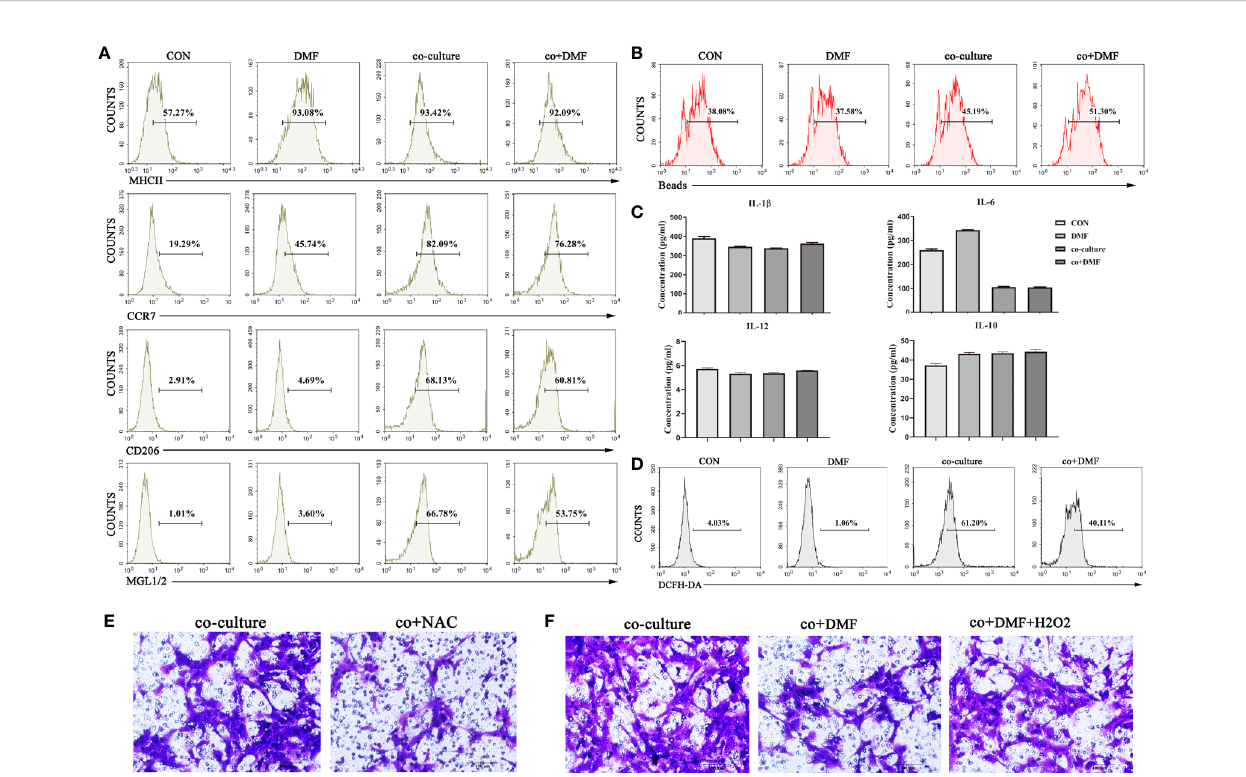
FIGURE 2 | DMF inhibits the pro-invasion ability of TAMs by reducing reactive oxygen species (ROS) production. (A) In the presence or absence of DMF, RAW264.7 cells were cultured alone or co-cultured with 4T1 cells for 48 hours, and the expression of membrane surface molecules (MHCII, CCR7, CD206, MGL1/2) of RAW264.7 cells was detected by fl ow cytometry. (B) In the presence or absence of DMF, RAW264.7 cells were cultured alone or co-cultured with 4T1 cells for 48 hours, and the phagocytosis of RAW264.7 cells was detected by fl ow cytometry. (C) In the presence or absence of DMF, RAW264.7 cells were cultured alone or co-cultured with 4T1 cells for 48 hours, and the secretion levels of TNF a , IL-6, IL-12, and IL-10 of RAW264.7 cells were assessed by enzyme-linked immunosorbent assay. (D) In the presence or absence of DMF, RAW264.7 cells were cultured alone or co-cultured with 4T1 cells for 48 hours, and ROS production in RAW264.7 cells was detected by fl ow cytometry. (E) In the presence or absence of N-acetylcysteine, 4T1 cells and RAW264.7 cells were co-cultured for 48 hours to detect the invasion ability of 4T1. (F) In the presence or absence of DMF or H 2 O 2 , 4T1 cells were co-cultured with RAW264.7 cells for 48 hours to assess the invasion ability of 4T1 cells. Data are presented as the mean ± SEM and represent at least three independent experiments with three